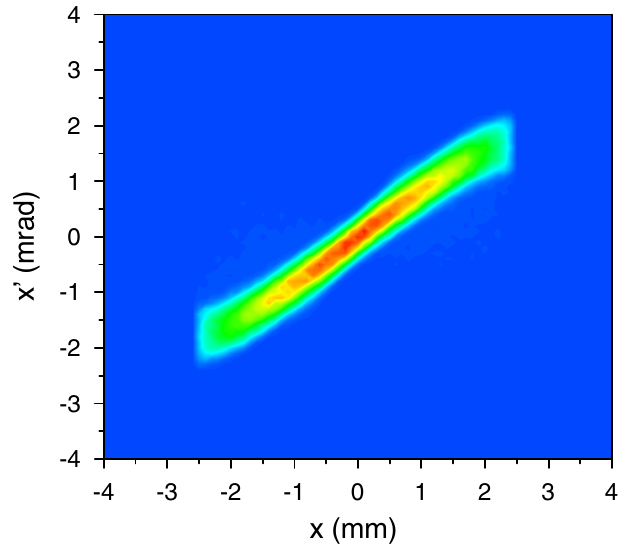
FIG. 5. (Color) Beam distributions in the horizontal phase space simulated using the